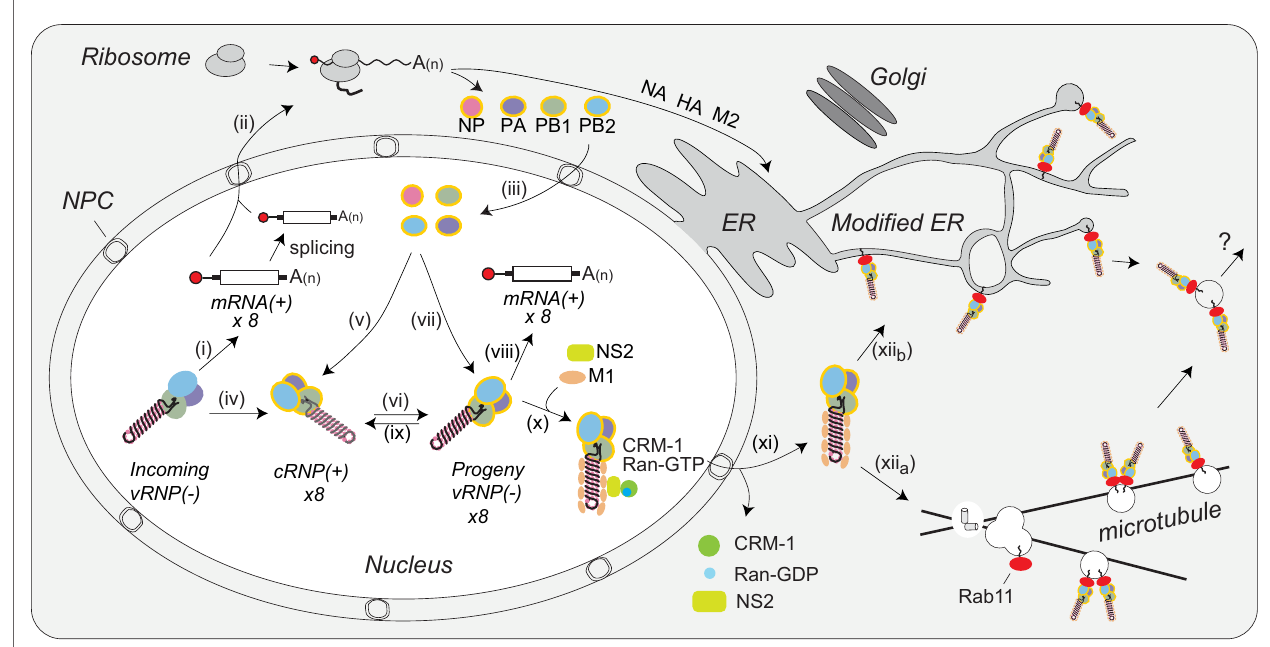
FigURe 5 | Coordination of viral ribonucleoprotein (vRNP) assembly and trafficking to the plasma membrane. Upon entry into the host cell nucleus, (i) the vRNP-associated viral polymerase transcribes the viral mRNAs. (ii) The mRNAs are either directly, or after alternative splicing, exported for translation by cytosolic ribosomes. (iii) Newly synthesized viral polymerase subunits (PA, PB1, and PB2) and nucleoprotein (NP) are imported back into the nucleus. (iv) Due to the inefficient dinucleotide priming, the vRNP-associated viral polymerase also infrequently transcribes complimentary RNA (cRNA) copies that assemble into cRNPs via (v) binding of a newly synthesized viral polymerase (PA, PB1, and PB2) and NP. (vi) The polymerase transcribes viral RNA (vRNA) copies from the positive strand in the cRNPs and these assemble into vRNPs by (vii) association with a new viral polymerase (PA, PB1, and PB2) and NP. Once assembled, the new vRNPs can (viii) transcribe additional viral mRNAs, (ix) transcribe new cRNA copies, or (x) associate with the newly synthesized viral proteins M1 and NS2 to facilitate the recruitment of CRM1, which (xi) mediates the nuclear export of the vRNP. (xii a ) Once exported, the vRNPs then associate with Rab11 that assists in the trafficking of the vRNPs toward the cell surface. The vRNP trafficking either occurs by Rab11-containing vesicles associated with microtubules or (xii b ) through Rab11 located in the modified endoplasmic reticulum (ER) membranes. How the vRNPs reach the budding site at the plasma membrane is currently not